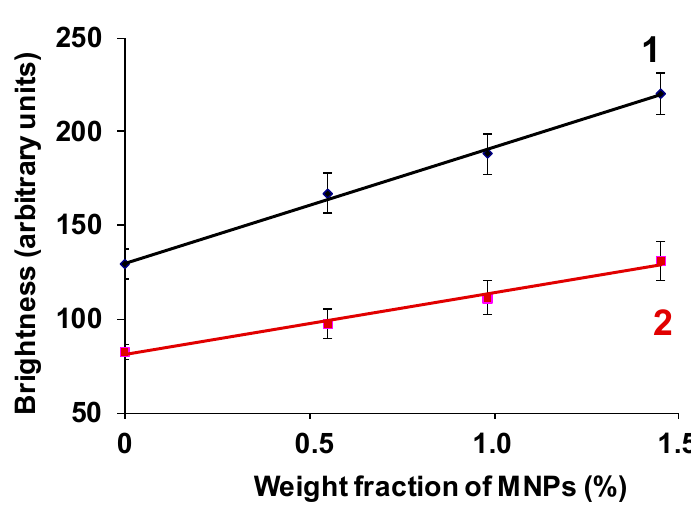
Figure 7. Dependences of maximum (1) and average brightness (2) at gel/water boundary on the MNPs concentration for samples of batch #2. Vertical bars reflect the confidence interval with p = 0.05.